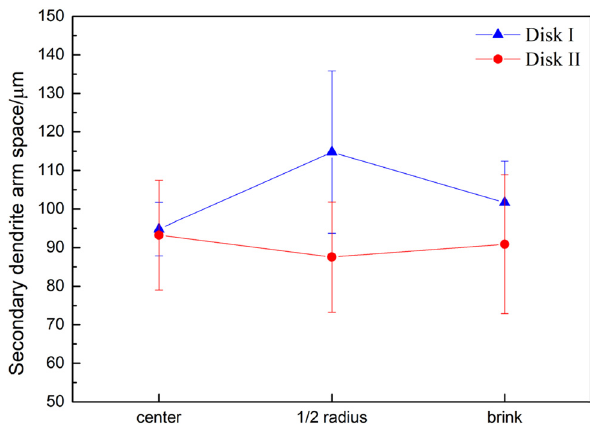
Figure 3: SDAS comparison between Disk I and Disk II.